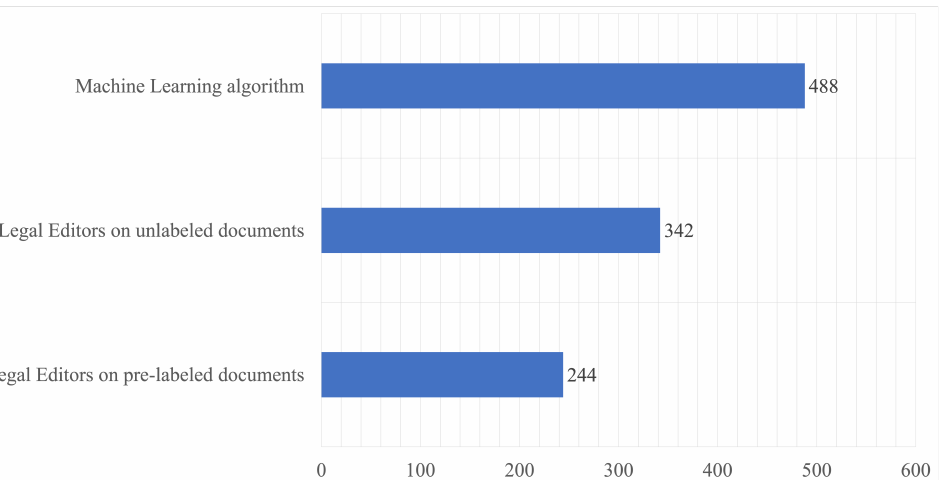
Figure 5. How many points the editors gained based on the extracted information content compared to the machine learning